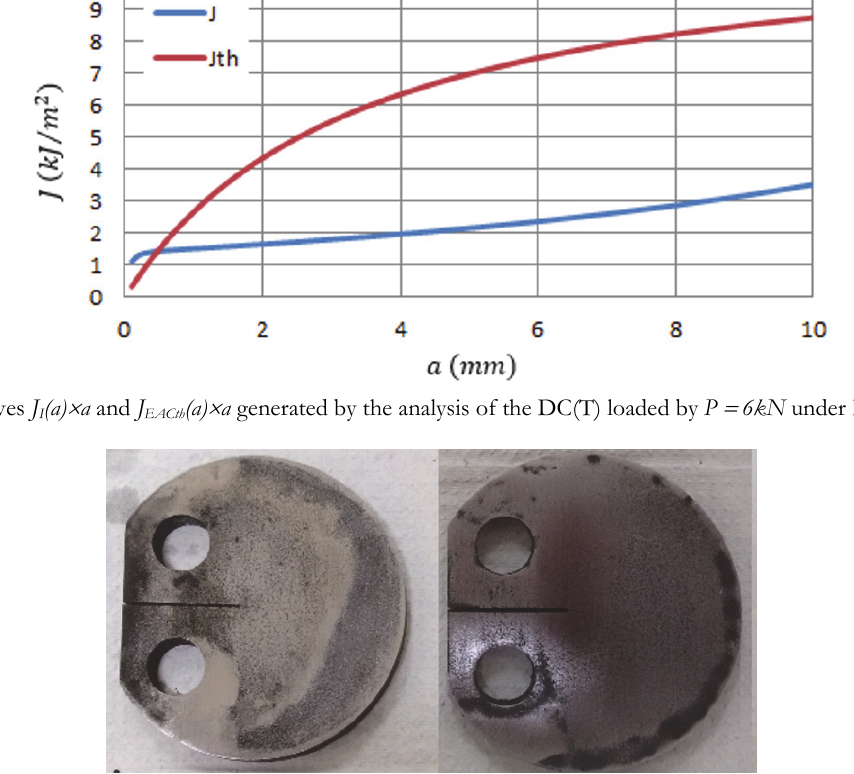
Figure 10: EP specimens after 30 days under EAC in aqueous hydrogen sulfide